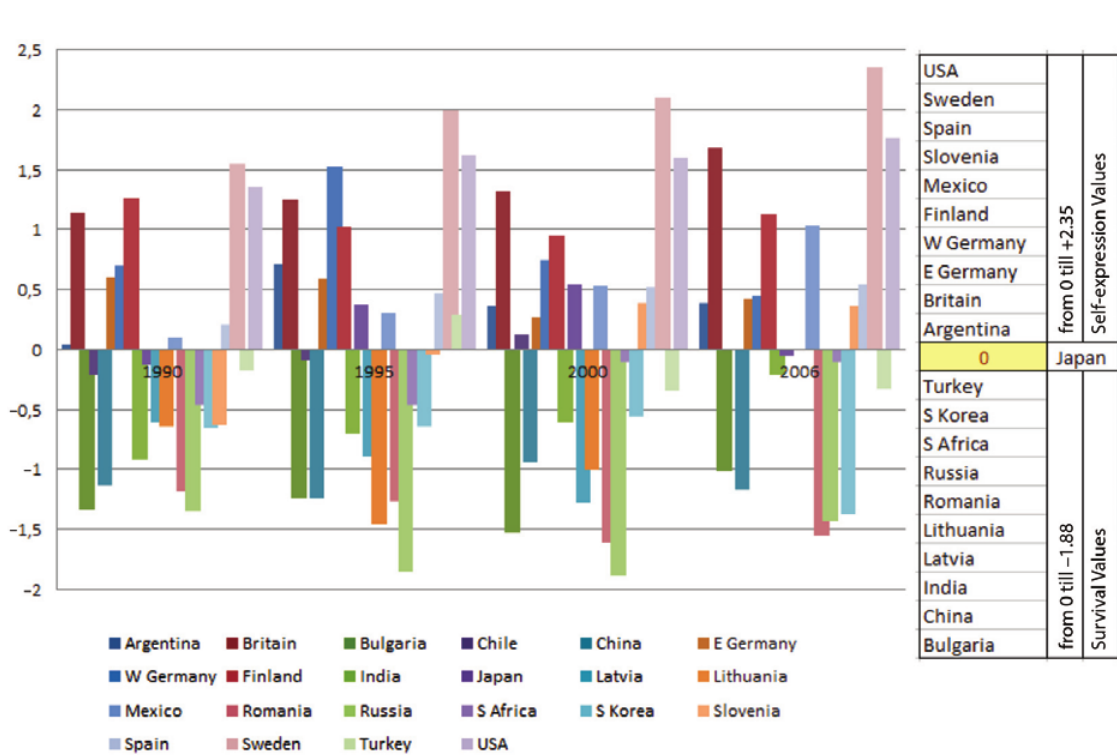
Figure 3. The shift from survival values (bottom part) to self-expression values (upper part) also includes a shift in child-rearing values, from emphasis on hard work toward emphasis on imagination and tolerance as important values to teach a child (World Values